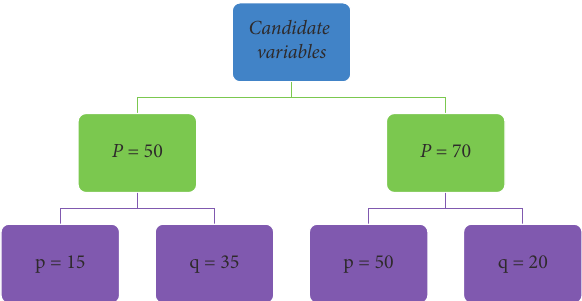
Figure 3: Distribution of candidate variables into relevant and irrelevant